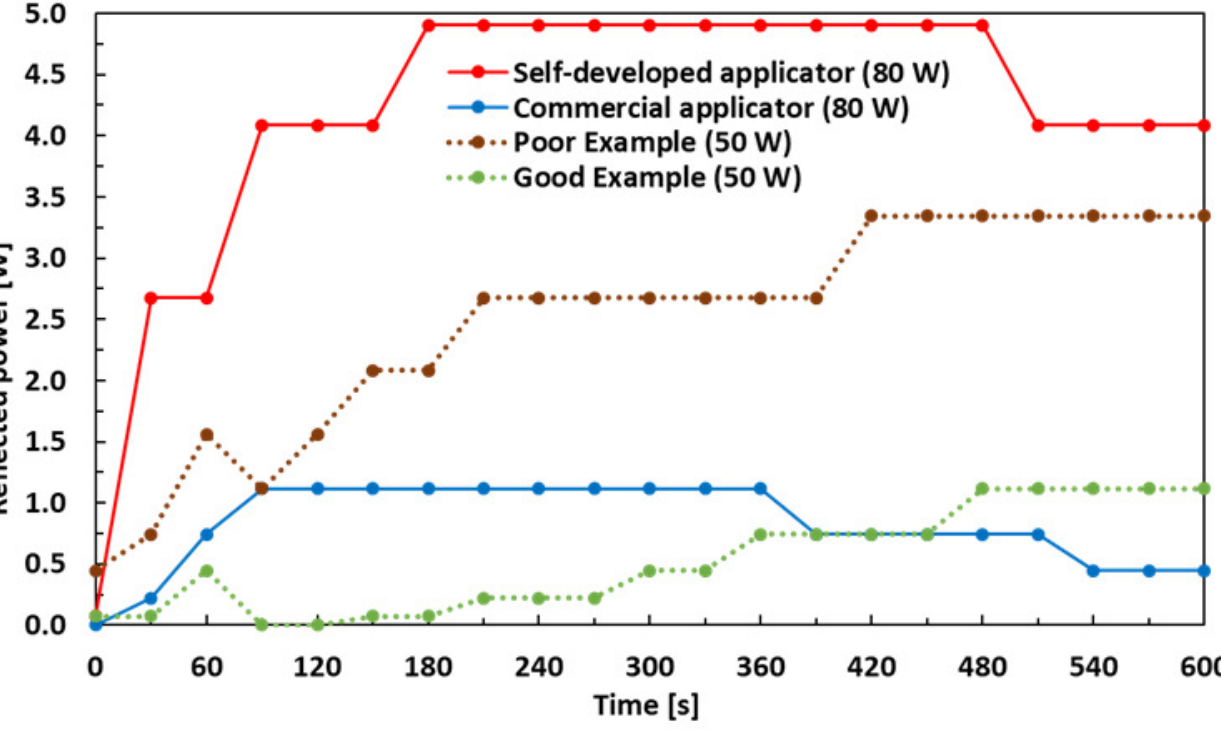
Figure A3. Comparison of reflected powers of commercial and self-developed applicators for 80 W MWA and poor and good examples of self-developed applicator matching for 50 W MWA in